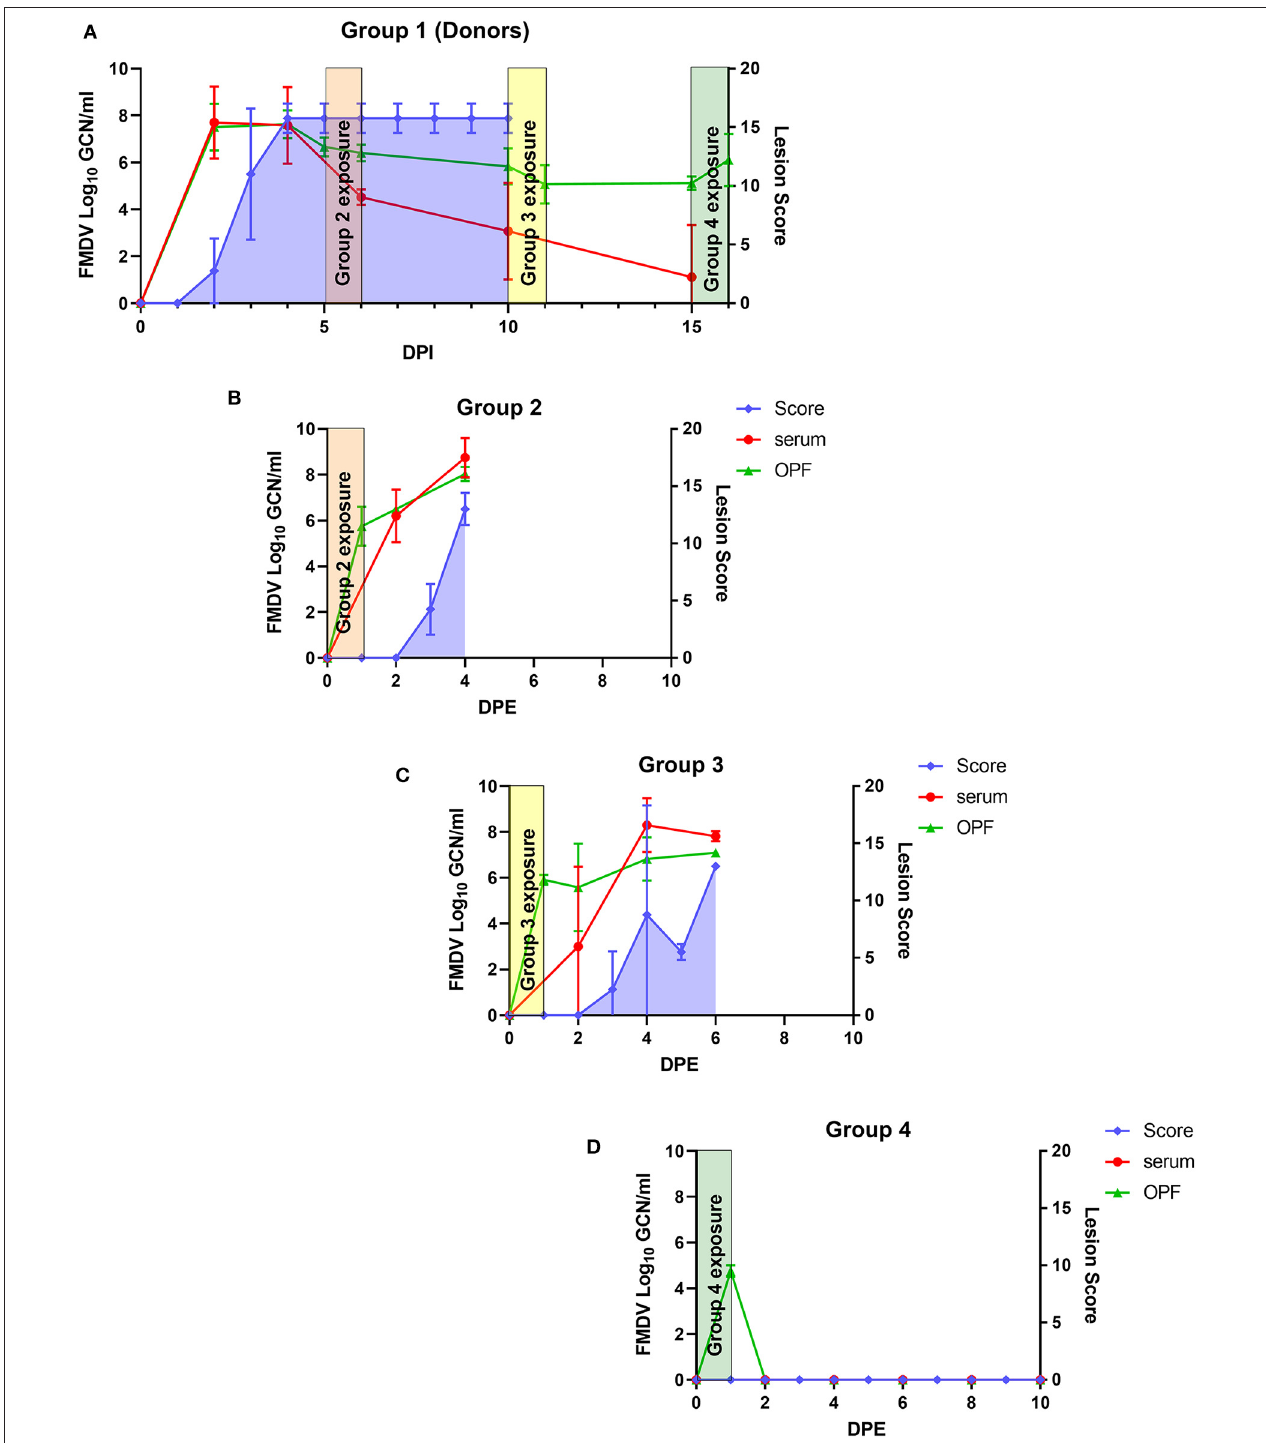
FIGURE 1 | Transmission dynamics of FMDV during late infection. (A) Four pigs in group 1 (donors) were infected with FMDV A24 Cruzeiro by intra-oropharyngeal inoculation on day 0. (B–D) The 4 donor pigs were subsequently co-mingled with study groups 2, 3, and 4, for 24h each, on days 5, 10, and 15 post infection, respectively. Graphs show average quantities (geometric means + /- standard deviation) of FMDV RNA (log 10 GCN/ml) in serum (red) and oropharyngeal fluid (OPF; green), as well as cumulative lesion scores (shaded blue). Orange, yellow, and green rectangles correspond to the time frame during which the donors were housed together with groups 2, 3, and 4,